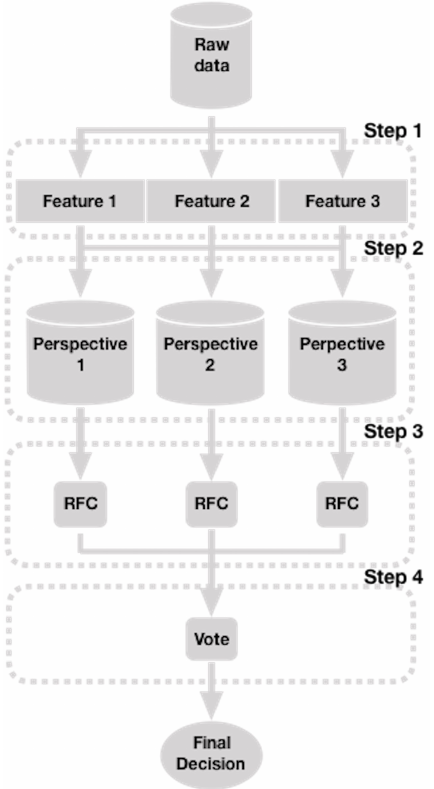
Figure 1. Overview of the method that predicts